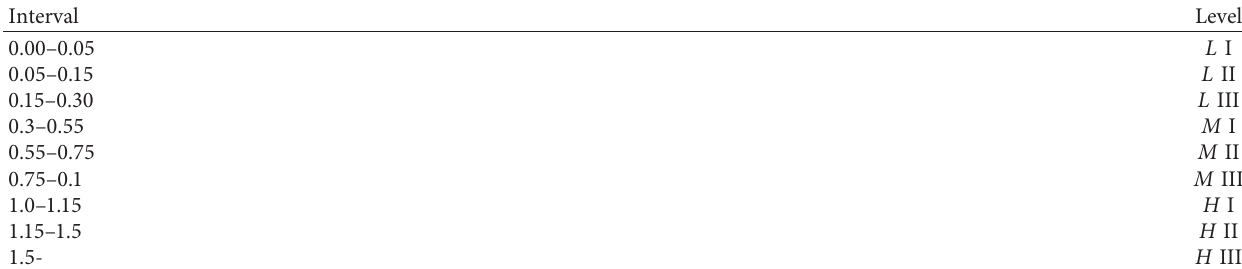
Figure 2: The trend of PCF depth in China from 2007 to 2018. Note. The left ordinate reflects the power carbon footprint and carbon bearing capacity, and the right ordinate reflects the power carbon footprint depth. The unit of the PCF and carbon bearing capacity is 10 6 hm 2 . Table 1: Power carbon footprint depth classification